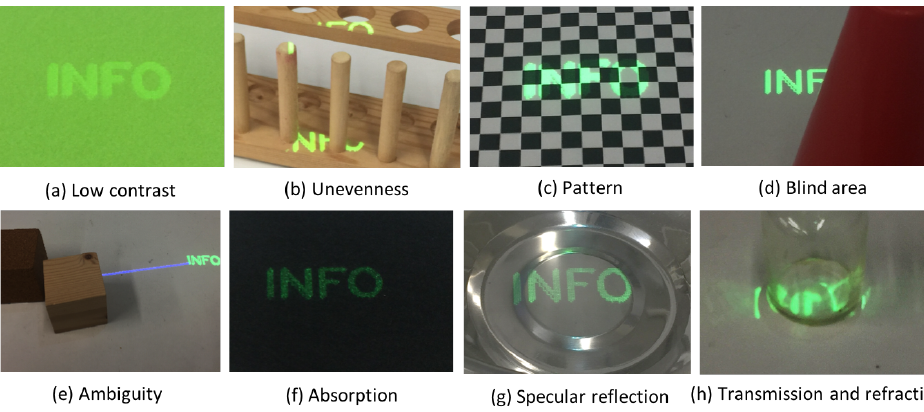
Figure 3. Categories of visibility degradation.